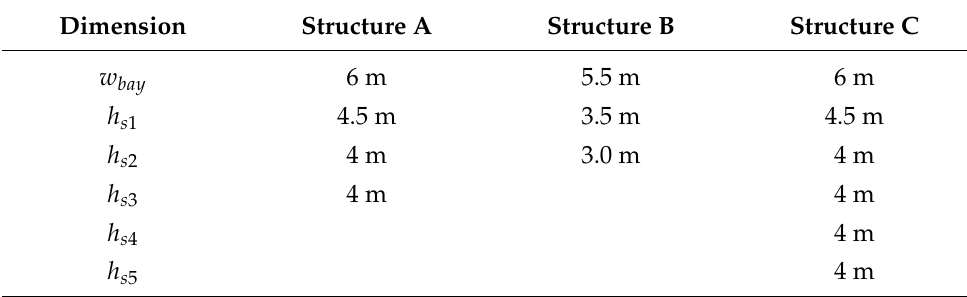
Table 2. Dimensions of the structures.